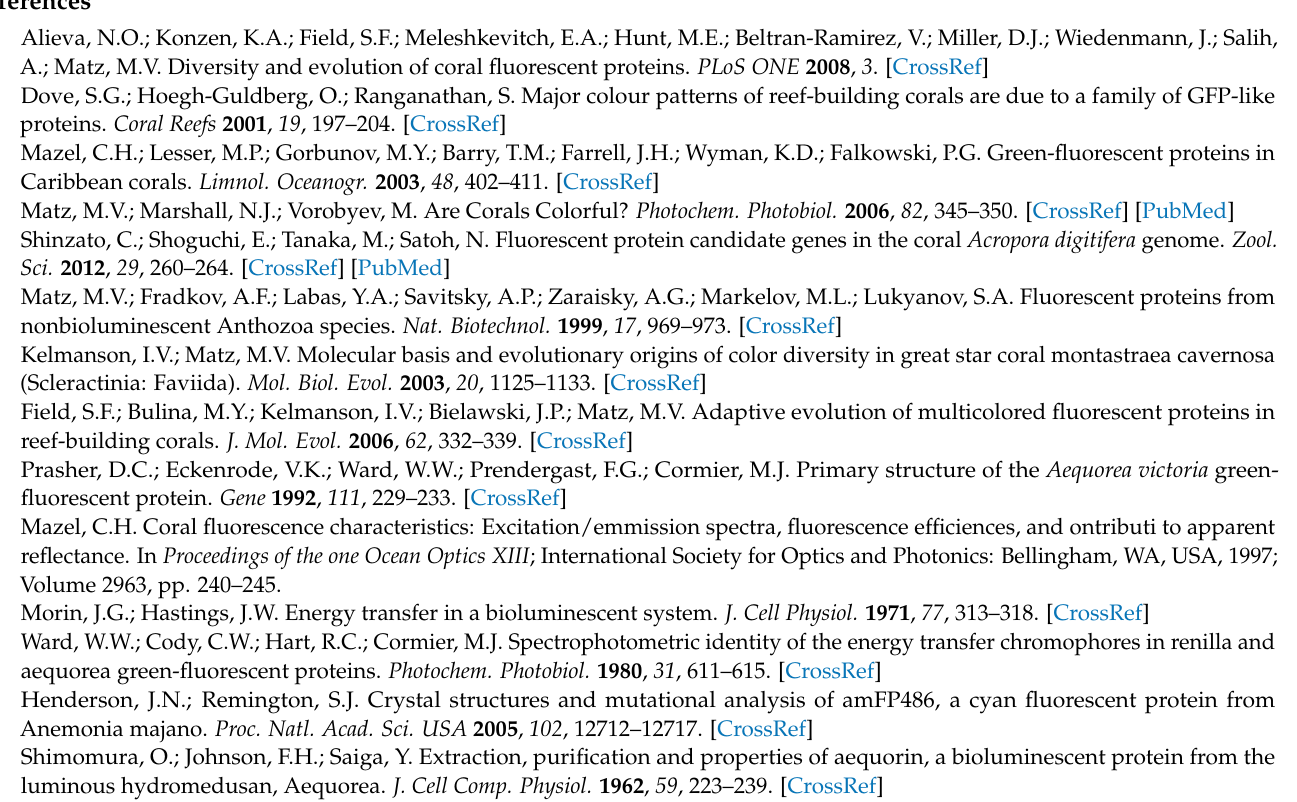
Notung software; Table S1. FP genes for preliminary analysis; Table S2. Analyzed FP genes; Table S3. Analyzed FP duplications and